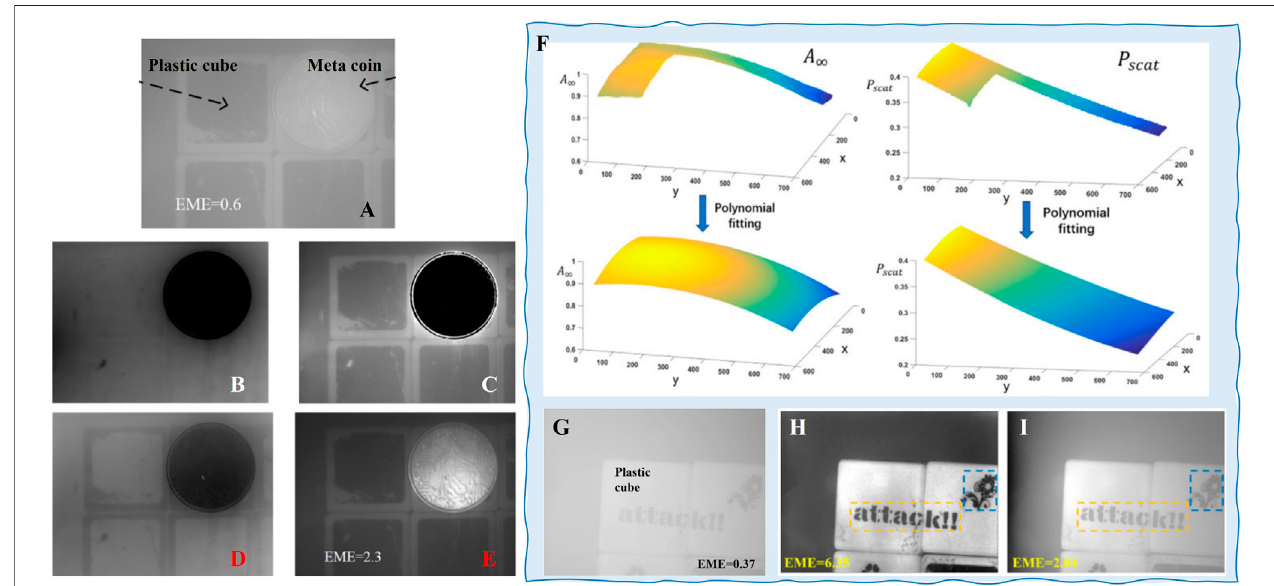
FIGURE 5 | (A) Raw image. The deduced (B) transmittance and the recovered (C) radiance of the objects when the light emanating from objects in the scene is unpolarized. The retrieved (D) transmittance and (E) radiance of the objects by Huang ’ s method (reprint from OSA: Optics Express [59], copyright 2016). (F) The fi tting spatial distribution of A ∞ and p . (G) Raw intensity image of the scene. (H) Recovered image by Hu ’ s and (I) Schechner ’ s methods [32] (reprint from IEEE: Photonics Journal [79], copyright 2018).